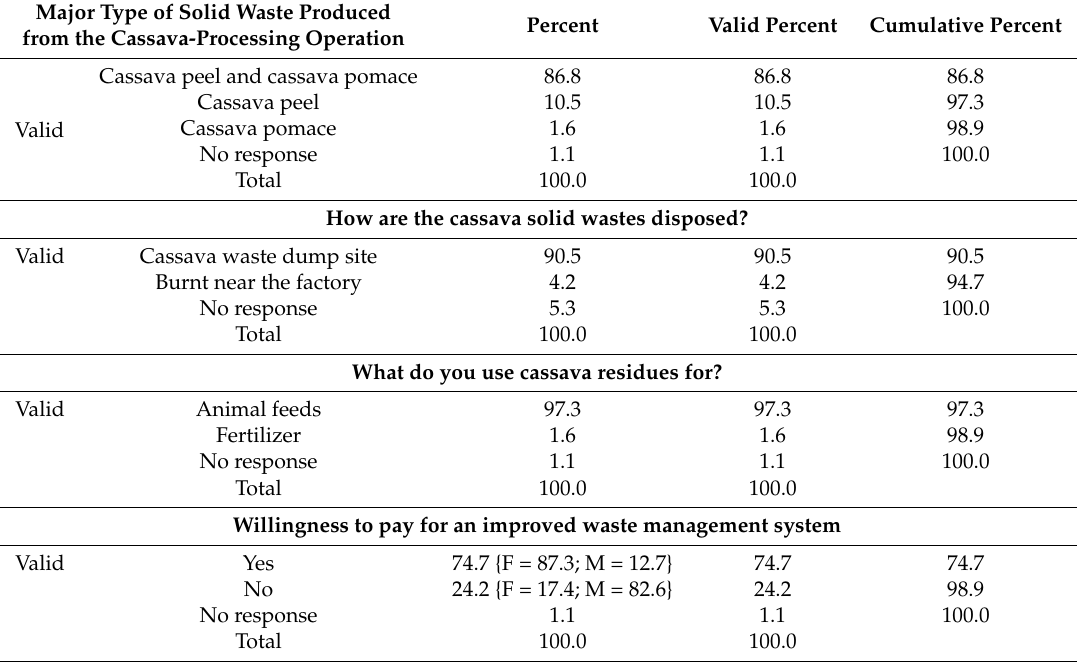
Table 1. Cassava-processing operations in the selected local government areas (LGAs).